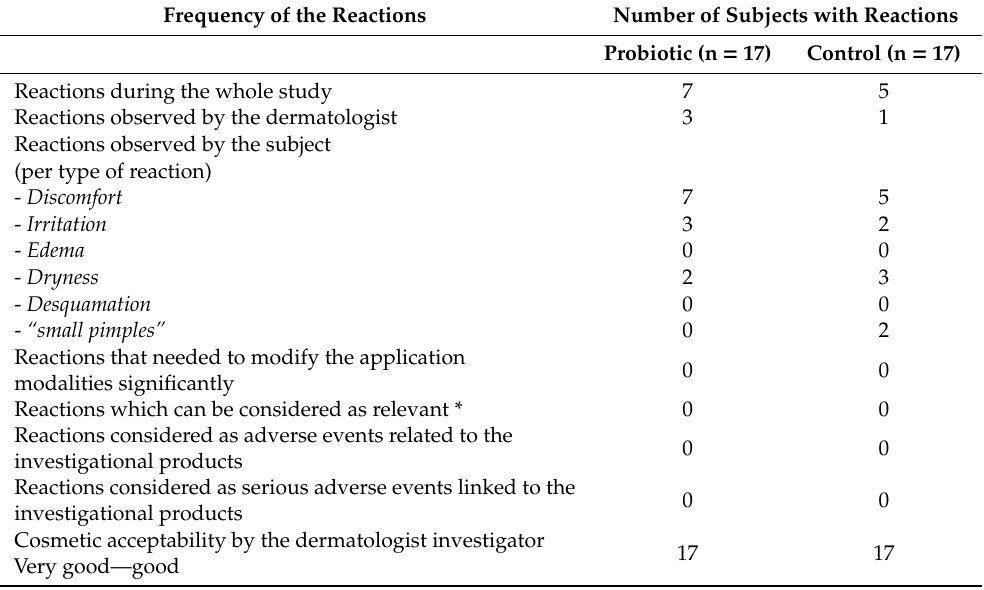
Table A1. Displaying the type and number of reactions observed throughout the study for evaluating cutaneous acceptability, the overall conclusion in cosmetic acceptability by the subjects, and cutaneous acceptability by the dermatologist